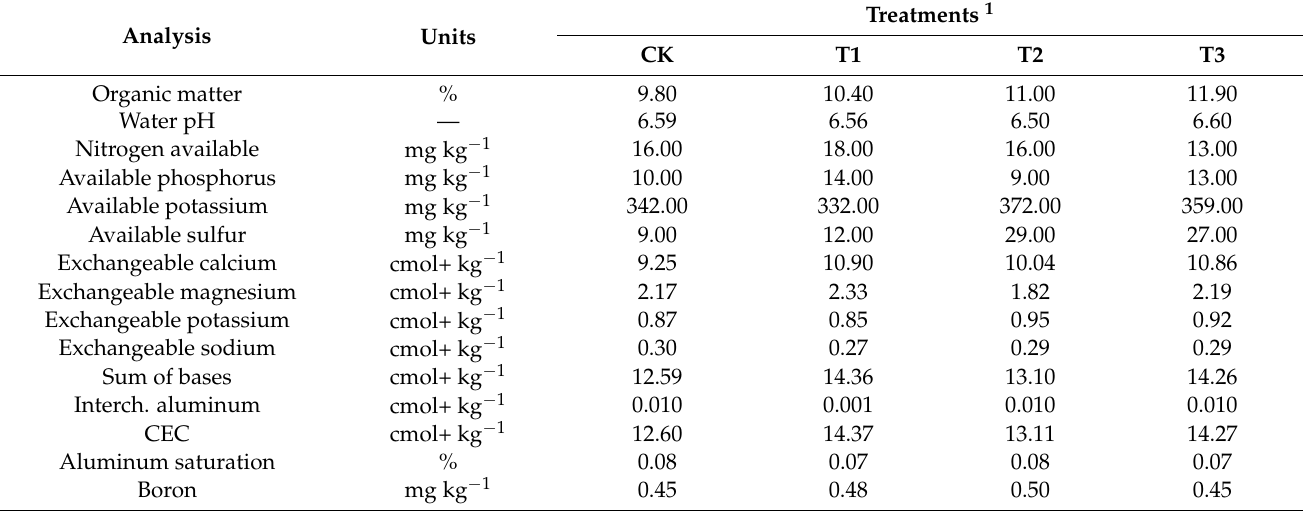
Table 3. Physicochemical analysis of the soil in the 2019/2020 season at the end of the study.